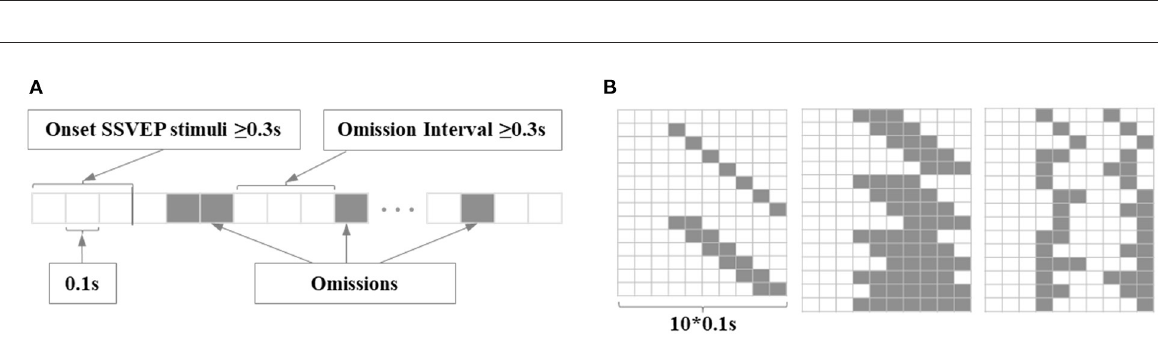
FIGURE14 (A) An extended application of the MTFSC method. Each square represents the 0.1s stimuli. Omissions with different duration and numbers are inserted into the SSVEP stimuli. The onset of SSVEP stimuli and the interval between omissions must be longer than 0.3s to produce stable SSVEP and OSP features. (B) An example of all stimuli sequences of 1s stimuli produced by the MTFSC method under one stimulation frequency. Each row represents one specific stimuli sequence, for a total of 44.